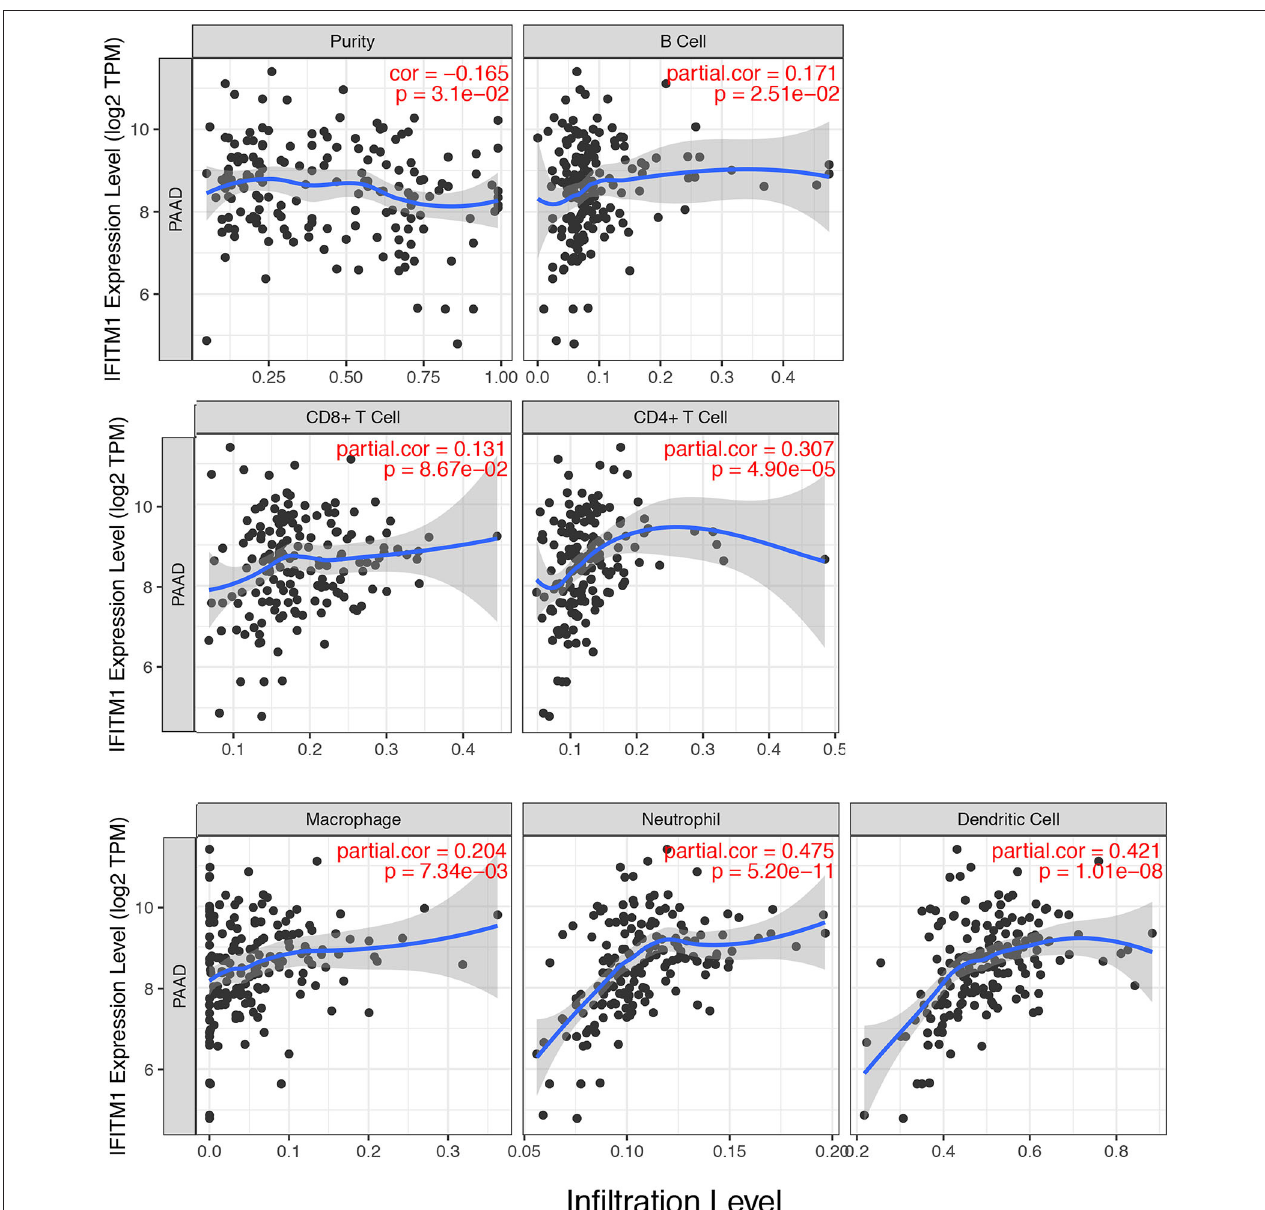
FIGURE 7 | The correlations between different IFITM1 expression and the immune cell infiltration (TIMER) in pancreatic cancer.